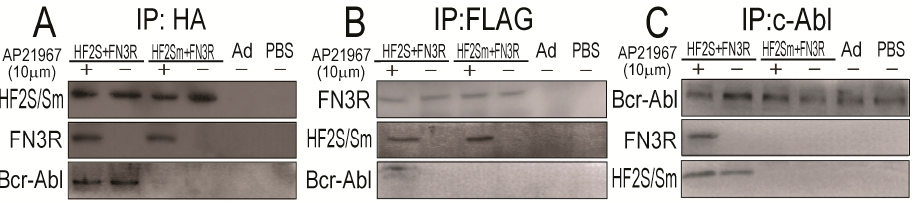
Figure 3. FN3R, HF2S and Bcr-Abl form complexus upon AP21967: Immunoblot analysis of FN3R, HF2S and Bcr-Abl immunoprecipitated with anti-HA ( A ); or anti-FLAG ( B ); or anti-c-Abl ( C ) from lysates of K562 cells treated with PBS, Ad5/F35-CMV (Ad), HF2Sm + FN3R, HF2Sm + FN3R + AP21967, HF2S + FN3R and HF2S + FN3R + AP21967.